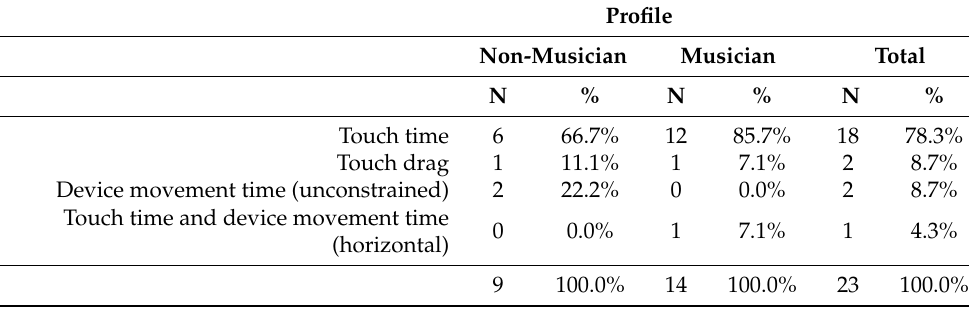
Table A4. Duration variation mapping (uncategorized)—stimulus b.